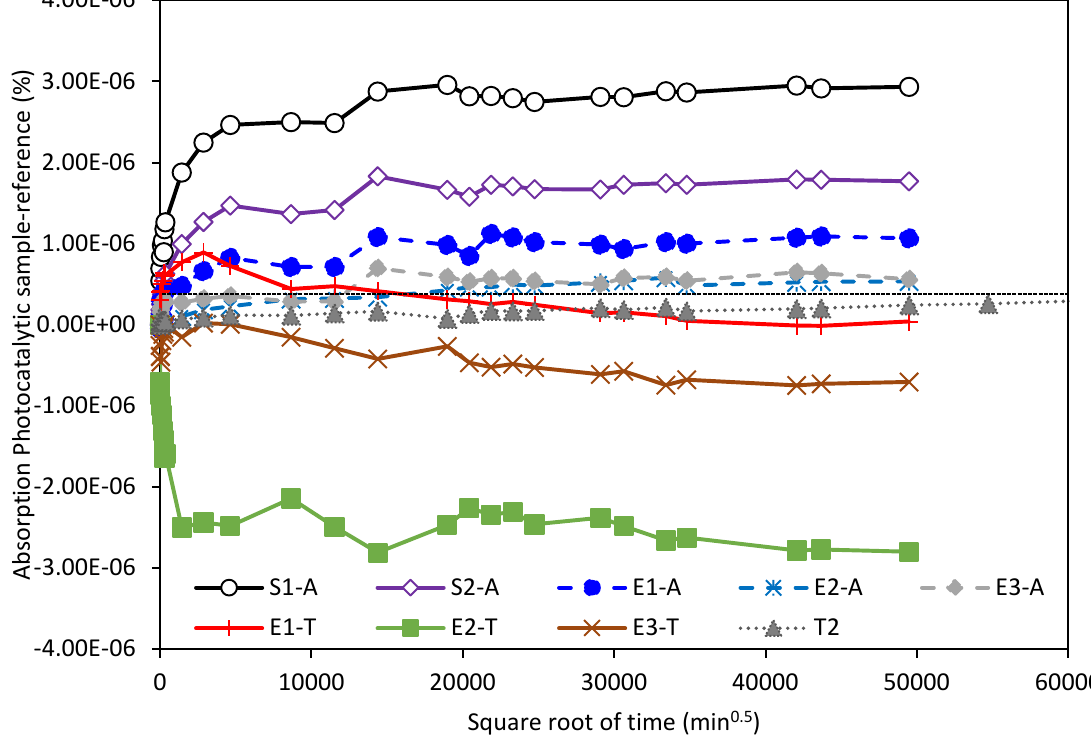
Figure 9. Percentage of water absorbed by the photocatalytic materials less absorption by the respective references.